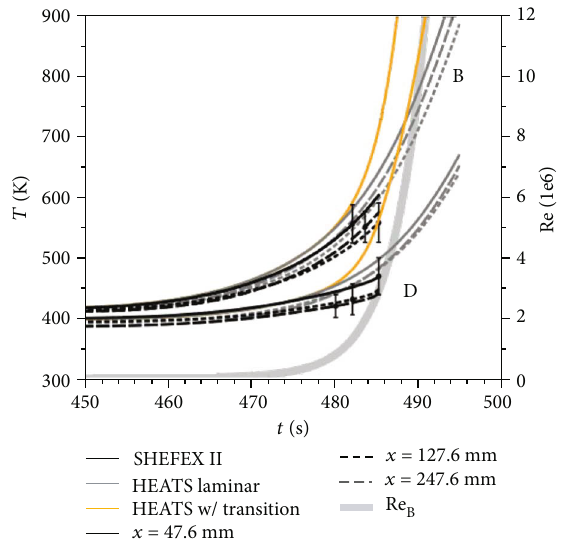
Figure 20: In- fl ight thermocouple data for the SHEFEX II trajectory (Figure 2) compared to prediction by HEATS.